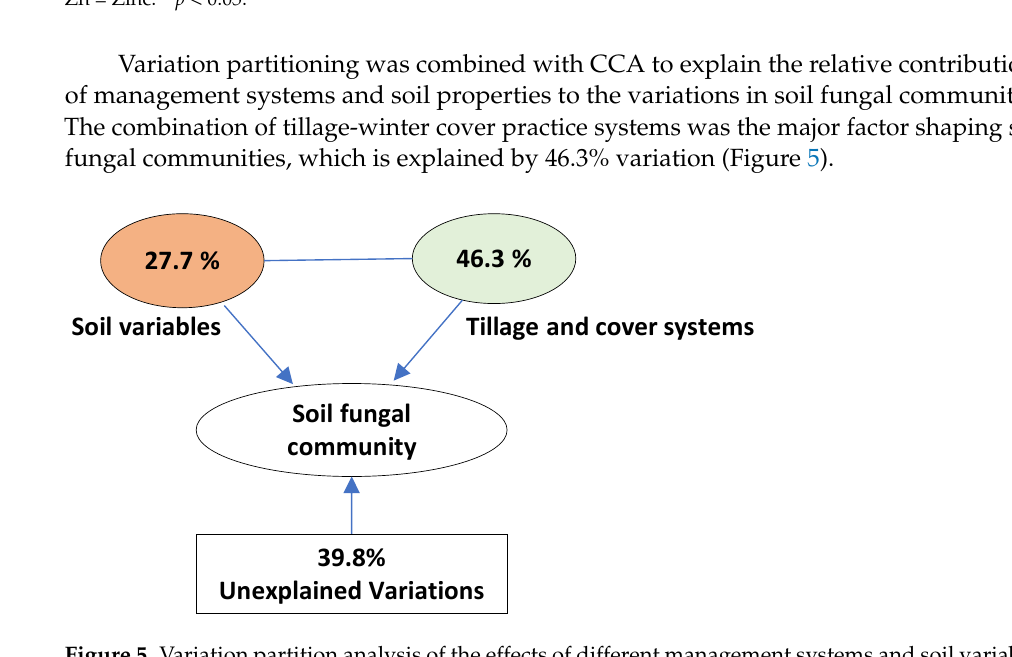
Figure 5. Variation partition analysis of the effects of different management systems and soil variables on the fungal community